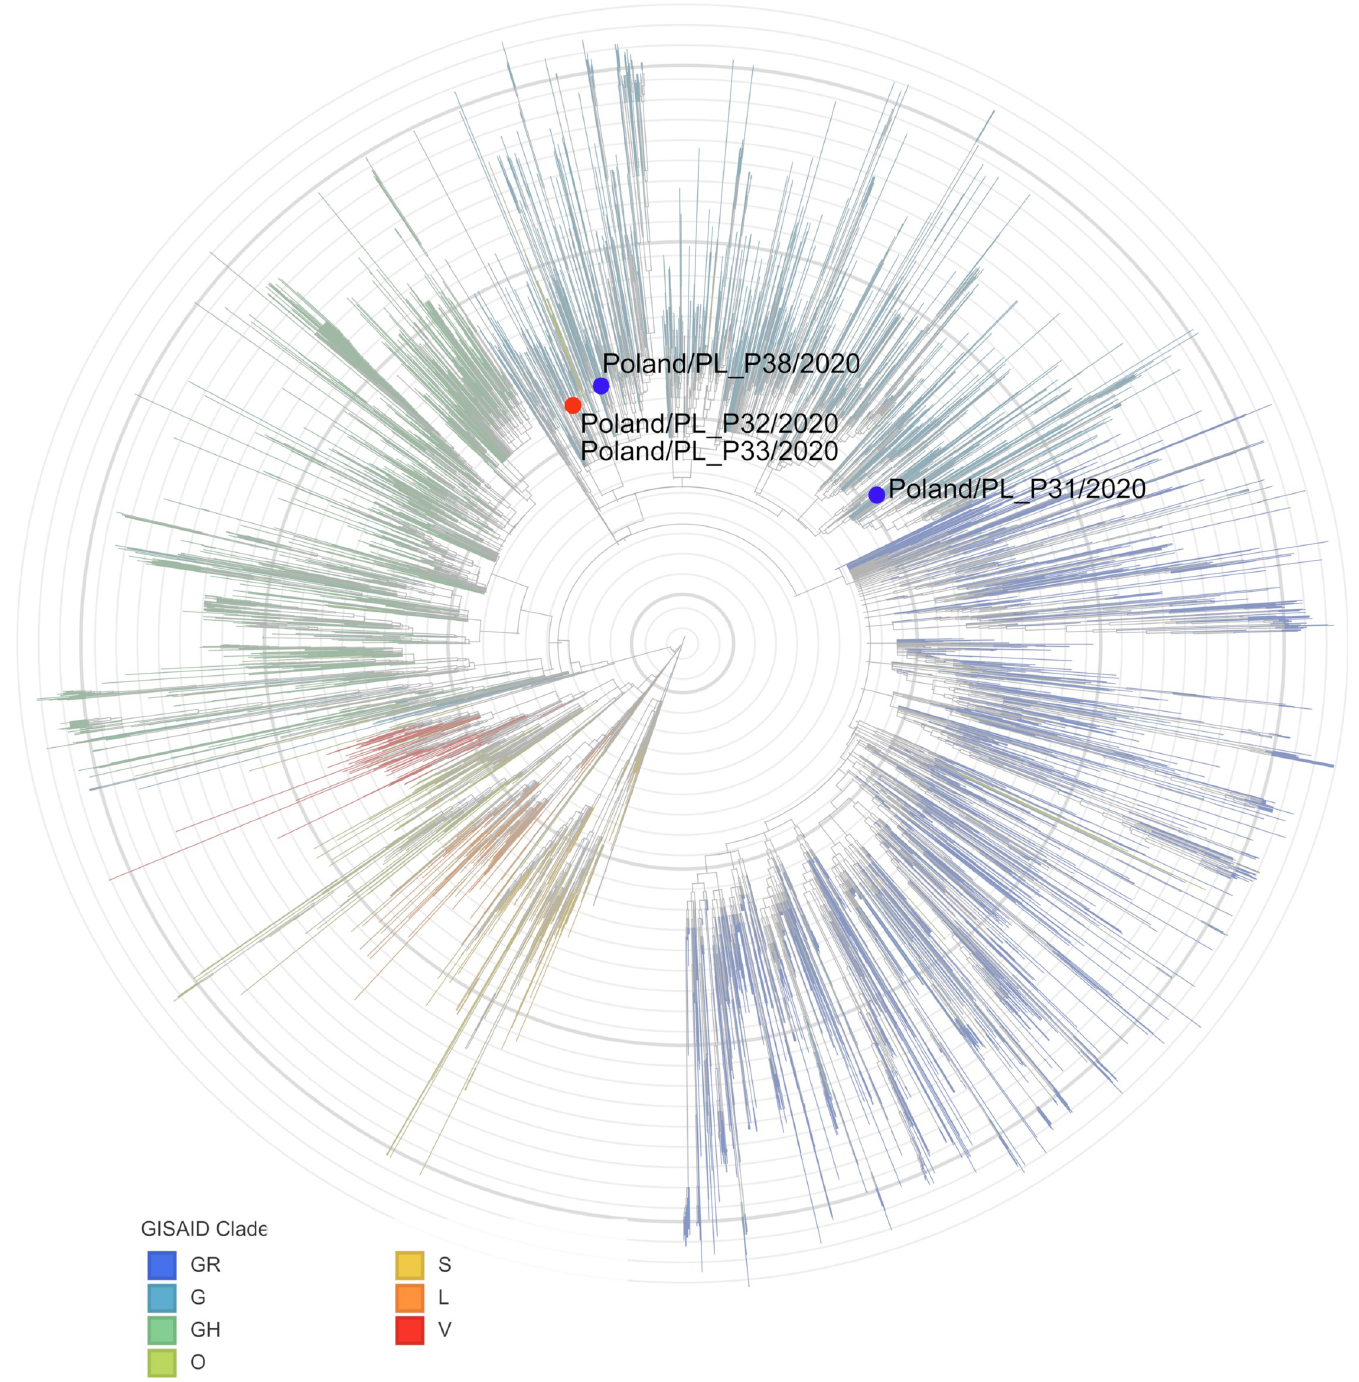
Fig 1. Phylogenetic analysis of the isolates included in the study. The analysis was carried out using the nexstrain server based on GISAID data [12,13],with the dataset dated on 4 th August 2020 [14,15]. The strains with the point mutation in the ORF10 are labeled in red, while the reference strains are labeled in blue. with intact ORF10 was observed. The genomes of all the strains were re-sequenced after the passage, and in all the cases, the sequences were identical to the ones observed for clinical isolates.